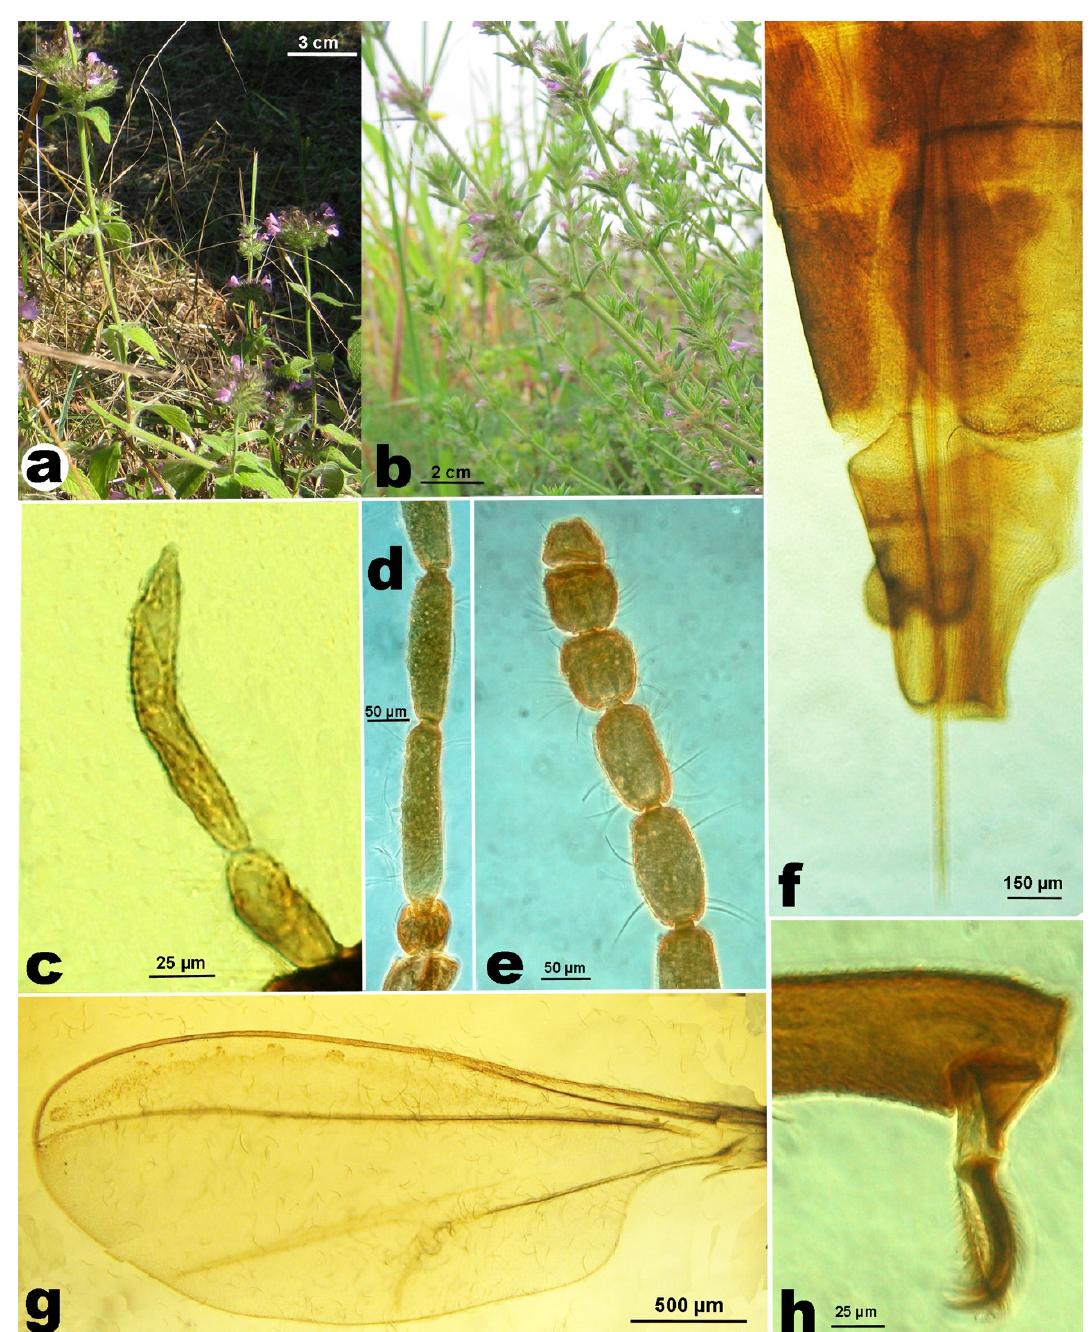
Figure 1. ( a ). Stems of Clinopodium vulgare with flowers. ( b ). Stems of Micromeria graeca subsp. graeca with flowers. ( c ). Asphondylia rivelloi , female, palpus. ( d ). Basal segments of antenna. ( e ). Distal segments of antenna. ( f ). Abdomen with ovipositor. ( g ). Wing. ( h ). Empodium and claws.